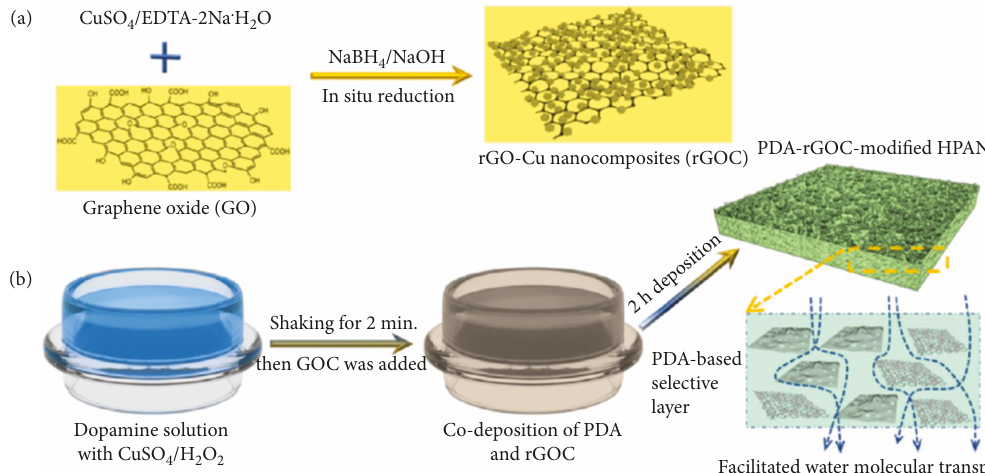
Figure 10: Schematic routes of (a) in situ growth of Cu NPs onto the surface of rGO nanosheets to make rGOC nanocomposites and (b) fast codeposition of PDA and rGOC nanocomposites triggered by CuSO